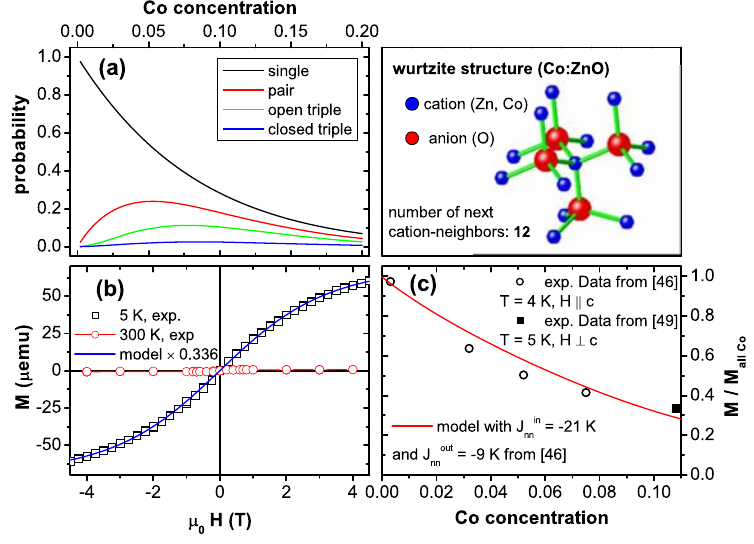
Figure 10. (a) Abundancies for various Co-O-. . . -configurations according to [143] for the cationic sublattice of wurtzite ZnO having 12 next cation